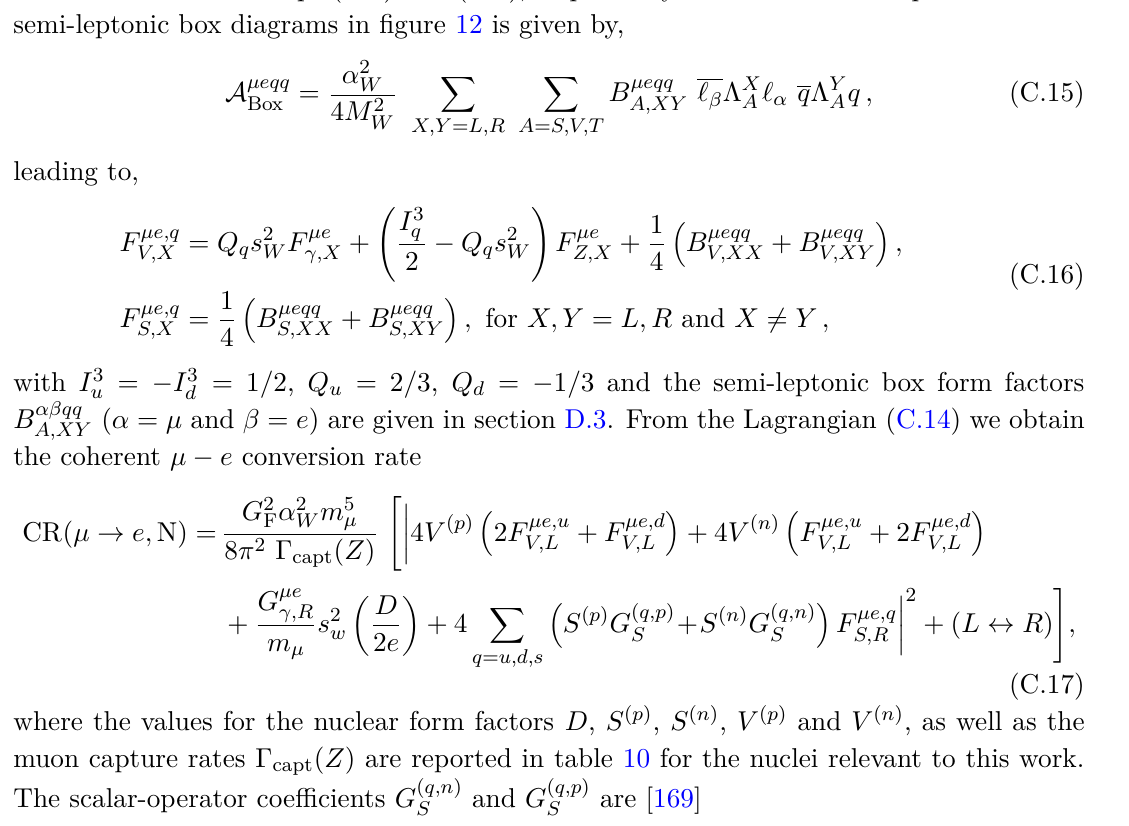
where G is the Fermi constant [68]. The form factors receive contributions from γ -penguin F and Z -penguin diagrams as shown in figure 10, the expression for their amplitudes are similar to the ones in eqs. (C.6) and (C.7), respectively. The transition amplitude for